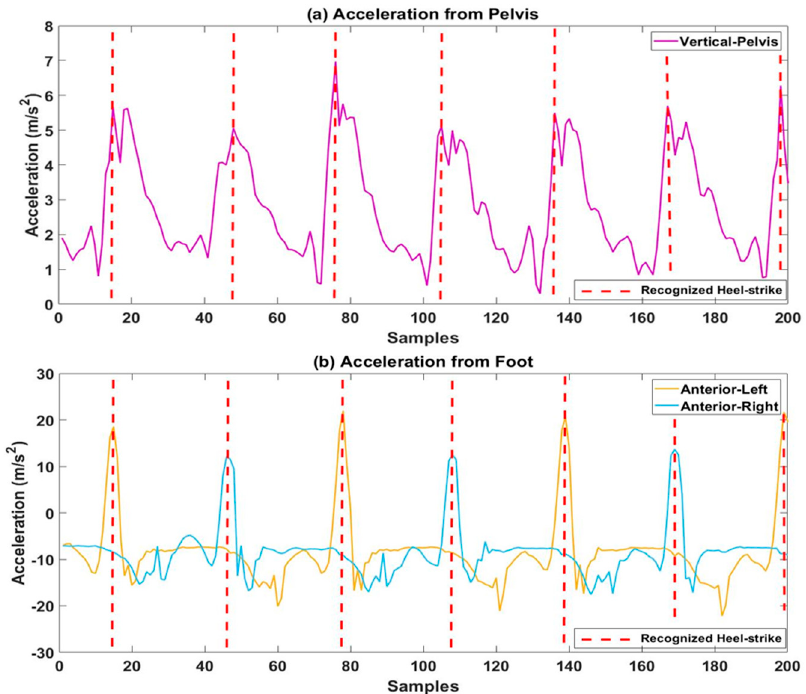
Figure 3. Recognized steps using accelerations from ( a ) pelvis and ( b ) foot. The step was recognized by detecting a heel-strike to another heel-strike. Red dotted lines represented the heel-strikes.